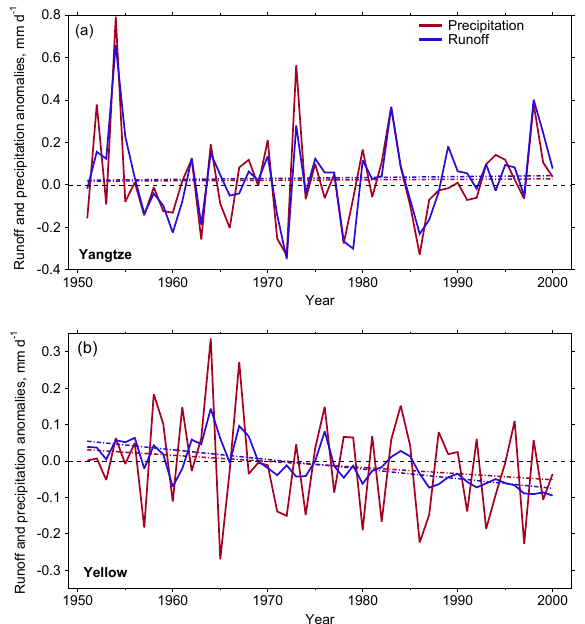
Figure 4. Observed runoff and precipitation anomalies for the Yangtze (a) and Yellow (b) River catchments for 1951–2000, rela- tive to 1961–1990. The dot-dashed lines show linear fits to the time series.